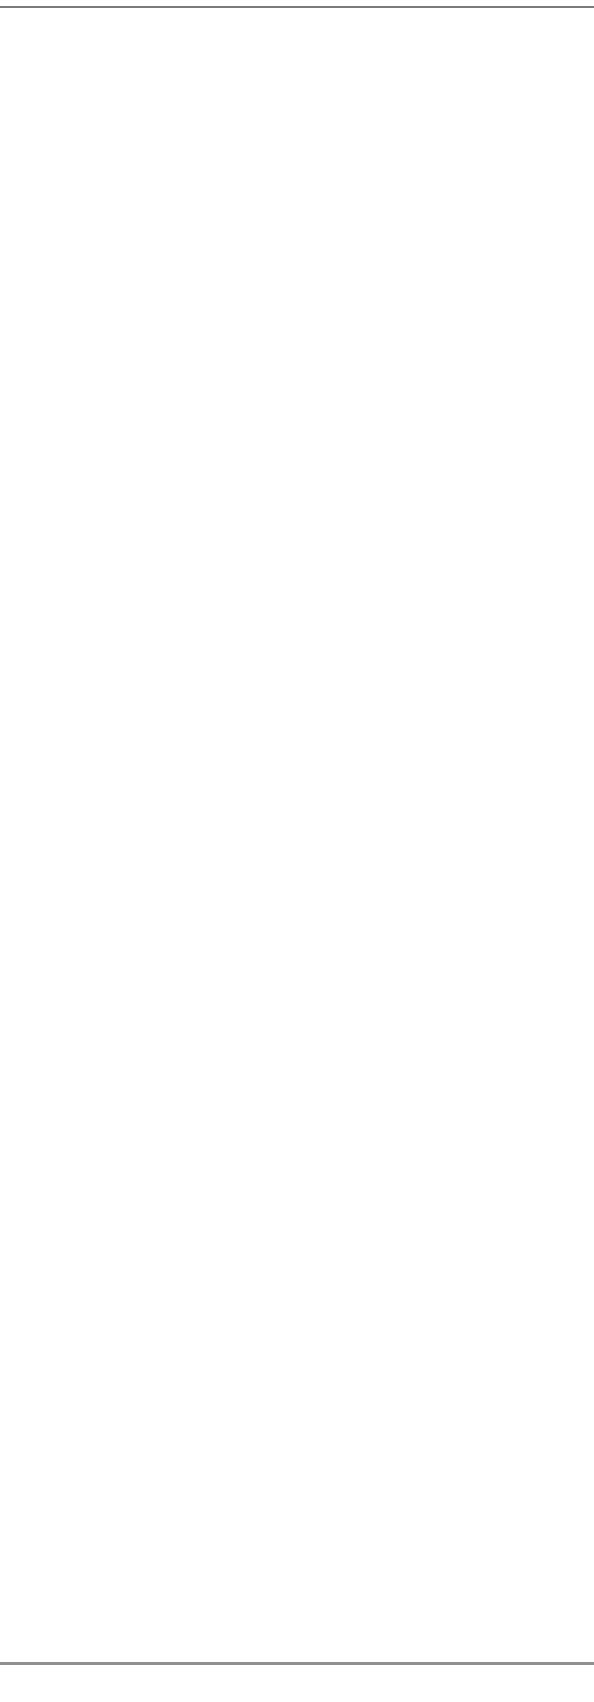
PLOS ONE | DOI:10.1371/journal.pone.0114068 December 4,